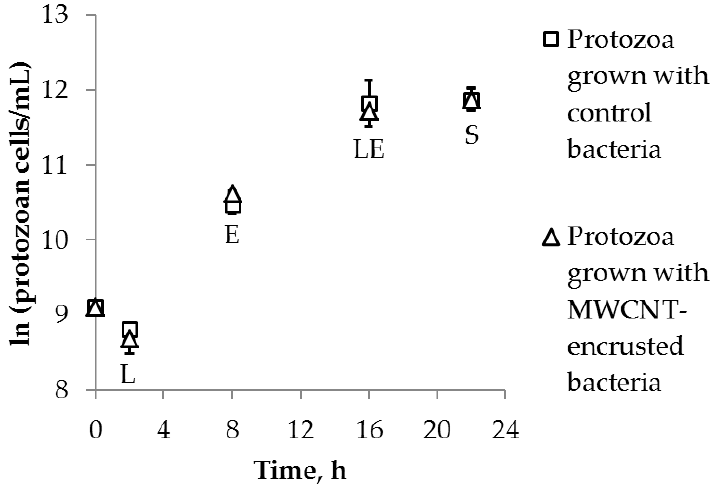
Figure 2. Natural log-transformed T. thermophila cell counts per milliliter over 22 h growth with control or MWCNT-treated P. aeruginosa as a food source. Data points are the average of three replicates, and error bars indicate standard deviation values. Letters designate growth phases: L—lag phase, E—exponential phase, LE—late exponential phase, and S—stationary phase.